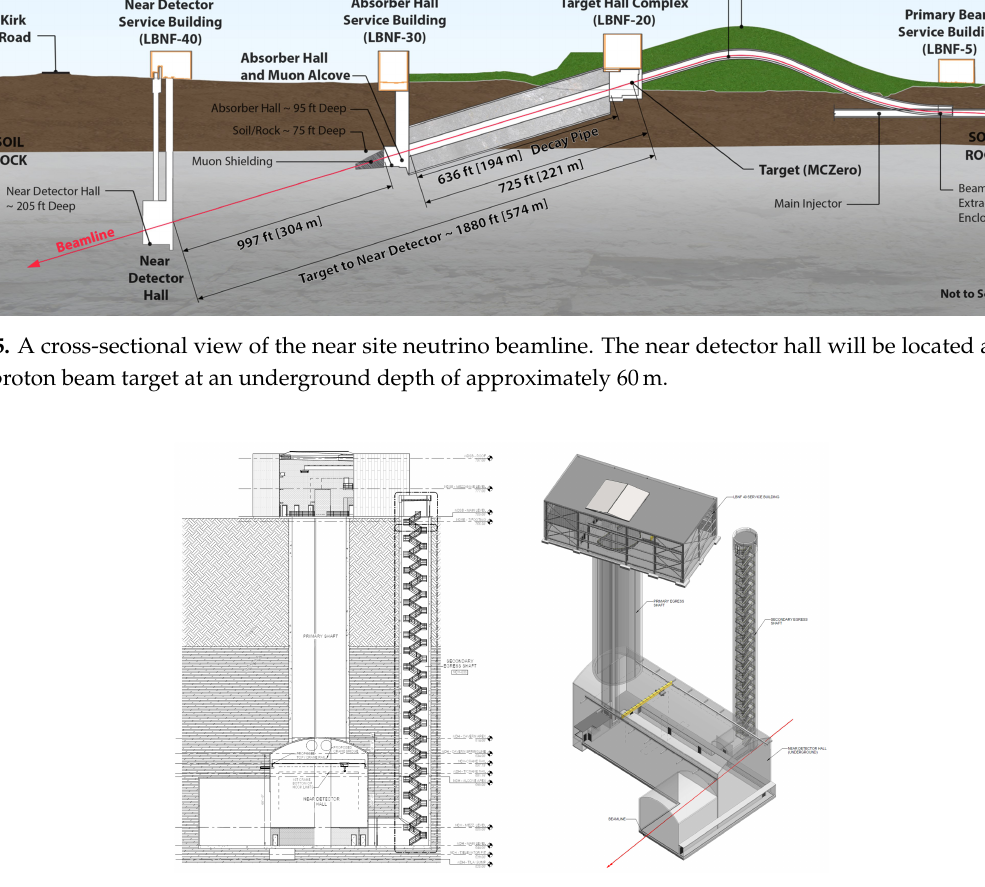
Figure 166. Near Detector cavern and surface building architectural